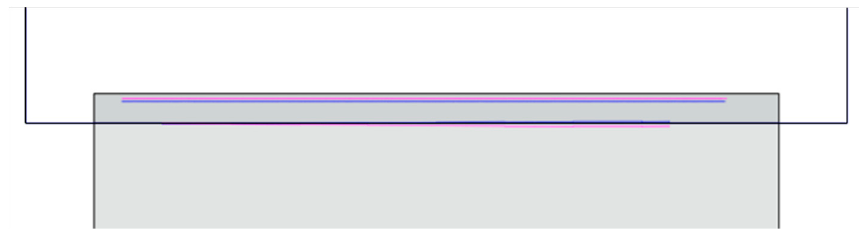
Figure 7. Side view measurements for Al and PUR 300.